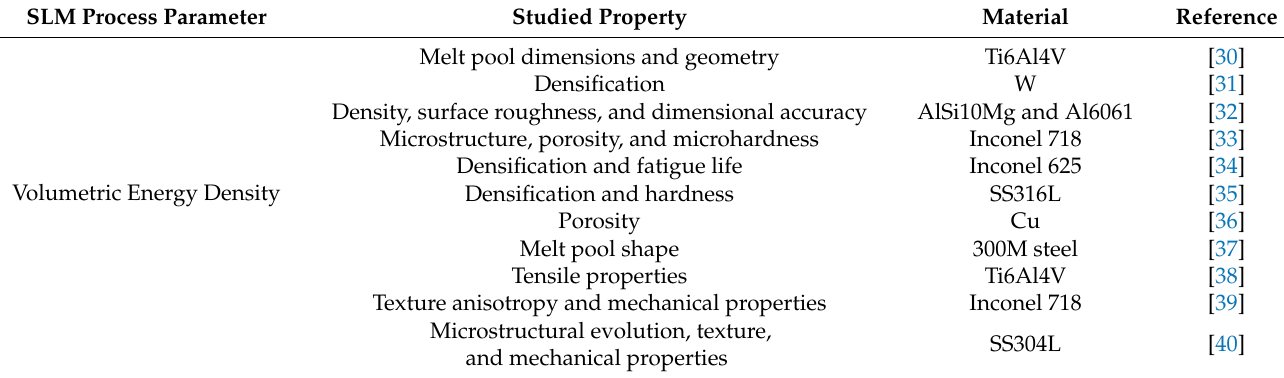
Table 2. Studies on the effect of volumetric energy density in